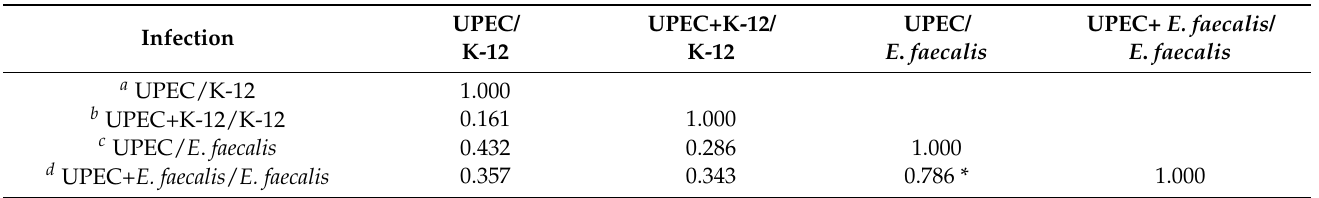
Table 1. Spearman correlation coefficient for the overall six pairwise associations among indices obtained from the different infections of the 5637 bladder cell line.